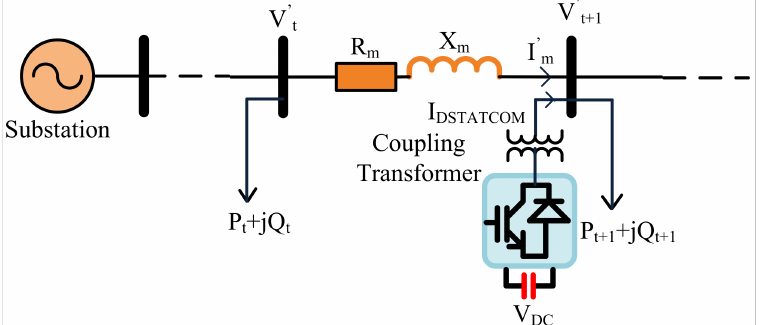
Figure 4. Single-line diagram of two consecutive nodes of a PDN with D-STATCOM at ( t + 1)th node.